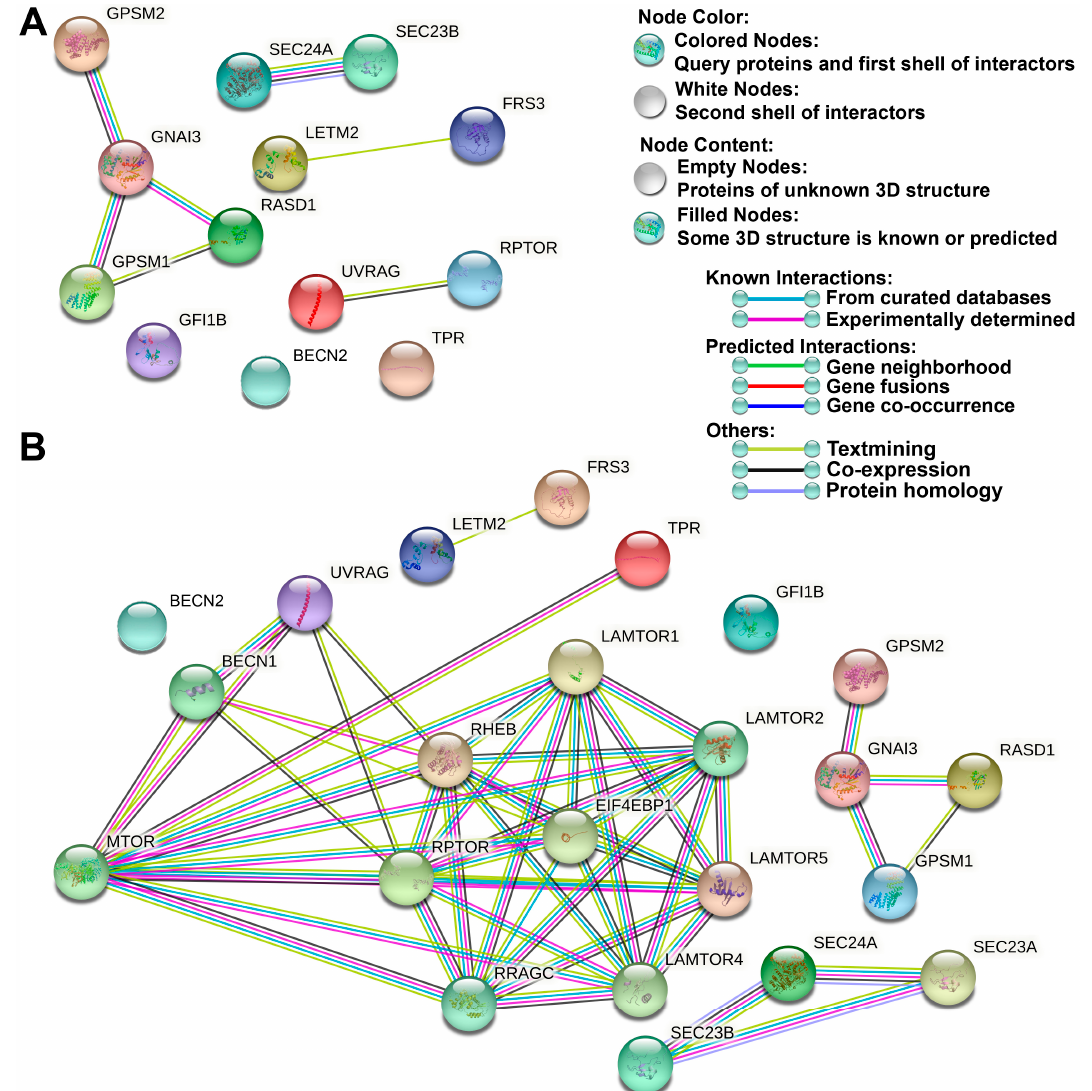
Figure 7. Autophagy protein interaction network between T1R skin lesions and THP-1 macrophages stimulated with M. leprae and IFN- γ . The 13 autophagy proteins codified by the upregulated genes in both T1R patients and treated THP-1 cells were visualized by STRING. ( A ) The evidence network view showing the 13 shared targets found in this study. In this view, colored lines between proteins indicate the various types of interactions. Network nodes represent proteins. Edges represent protein–protein associations. ( B ) More proteins were added to the evidence network shown in ( A ) to show the interaction of the 13 shared targets with core autophagy machinery proteins.